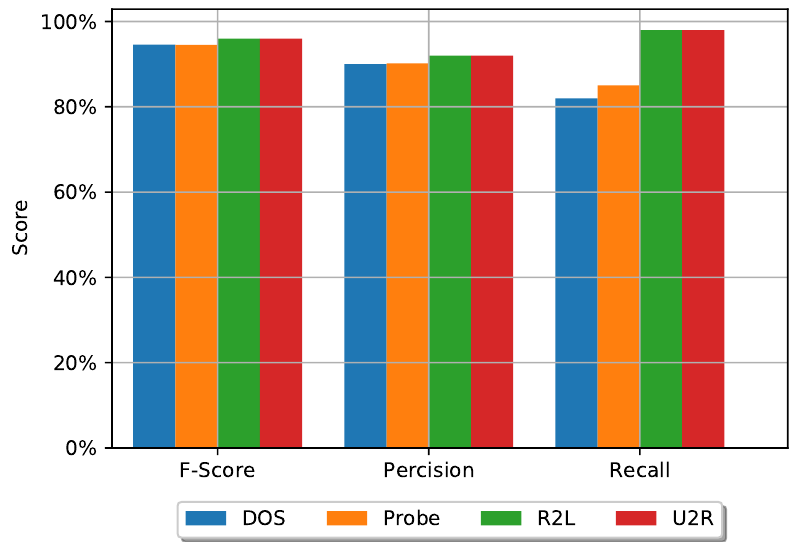
Figure 7. Performance evaluation of the proposed model in detecting attacks for each category, using F-score, precision and